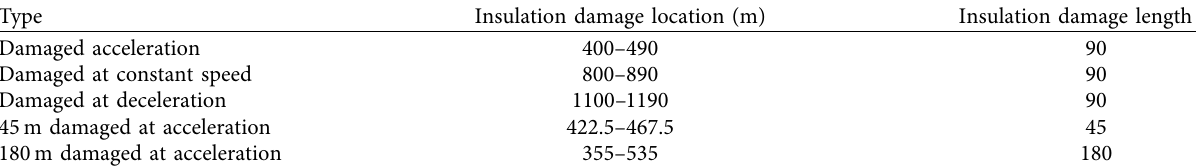
Table 2: Location and length parameters of rail insulation damage.